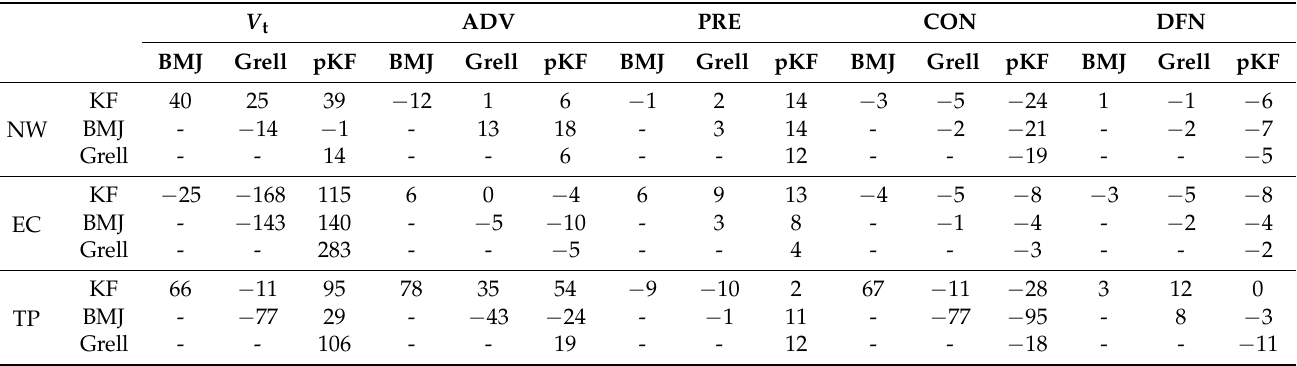
Table 3. The difference index (DIF) in different CPS-ensemble area-averaged summer mean integral results of the five terms in Equation (1) for the sub-regions, corresponding to the value of the vertical CPS minus the one of the horizontal CPS (unit: